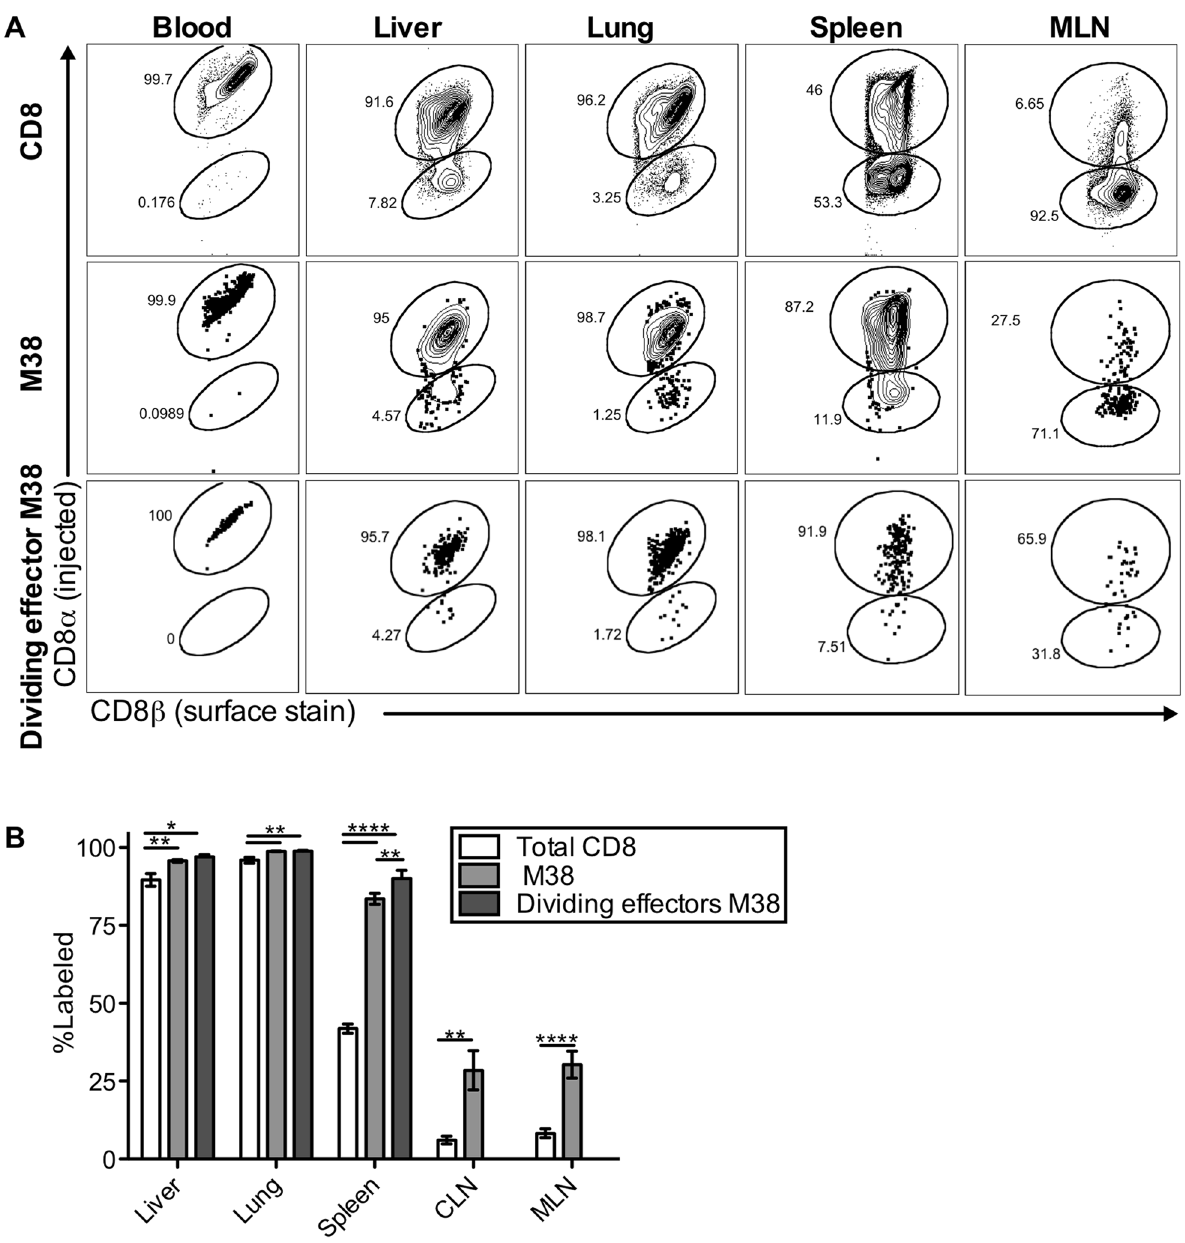
Figure 5. Most inflationary CD8s are exposed to the blood supply. Mice infected with K181 MCMV for more than 3 months were injected with fluorochrome labeled anti-CD8 a antibody to identify T cells exposed to the blood supply. After perfusion and processing the organs, cells were counterstained with anti-CD8 b , to identify all CD8 T cells. (A) Shown is representative FACS staining with the injected antibody for all CD8s (top), M38- specific CD8s (middle), and dividing effector-phenotype M38-specific CD8s (bottom) in the blood, spleen, liver, lung and mediastinal lymph nodes. (B) Graph shows mean frequency of cells labeled by i.v. staining for all CD8s, M38-specific CD8s, and dividing effector-phenotype M38-specific CD8s for the indicated organs. Data are pooled from 4 independent experiments (n=15) and representative of seven independent experiments. Statistical significance was measured by paired student’s t-tests (*p , .05, **p , .01, ***p , .001, **** p , .0001). Error bars represent the standard error of the